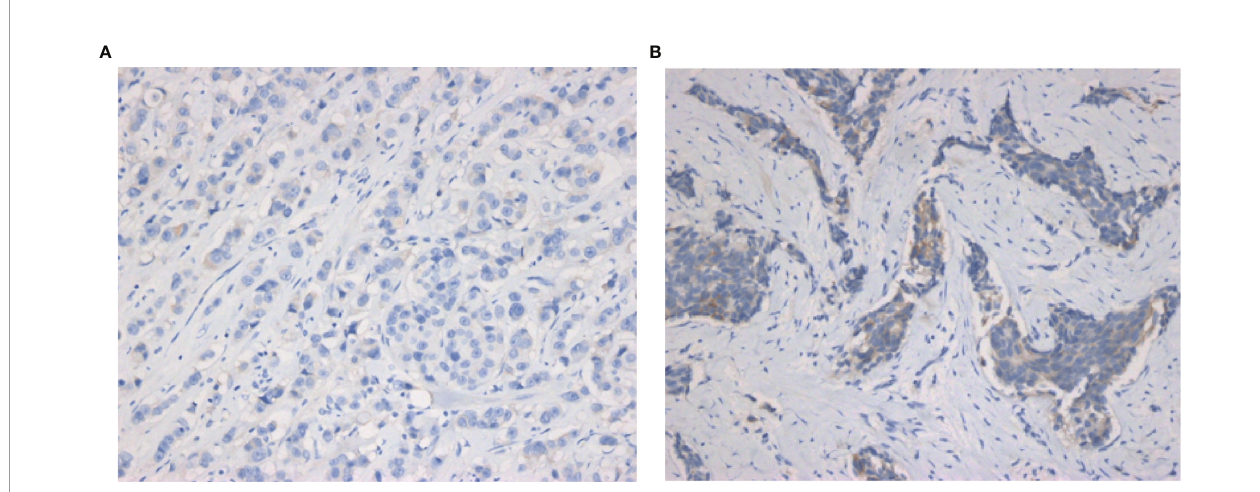
FIGURE 1 | Representative IHC images of HER2-zero and HER2-low breast cancers. (A) IHC images of HER2-zero breast cancer. (B) IHC images of HER2-low breast cancer (magni fi cation ×200 in each picture). IHC,